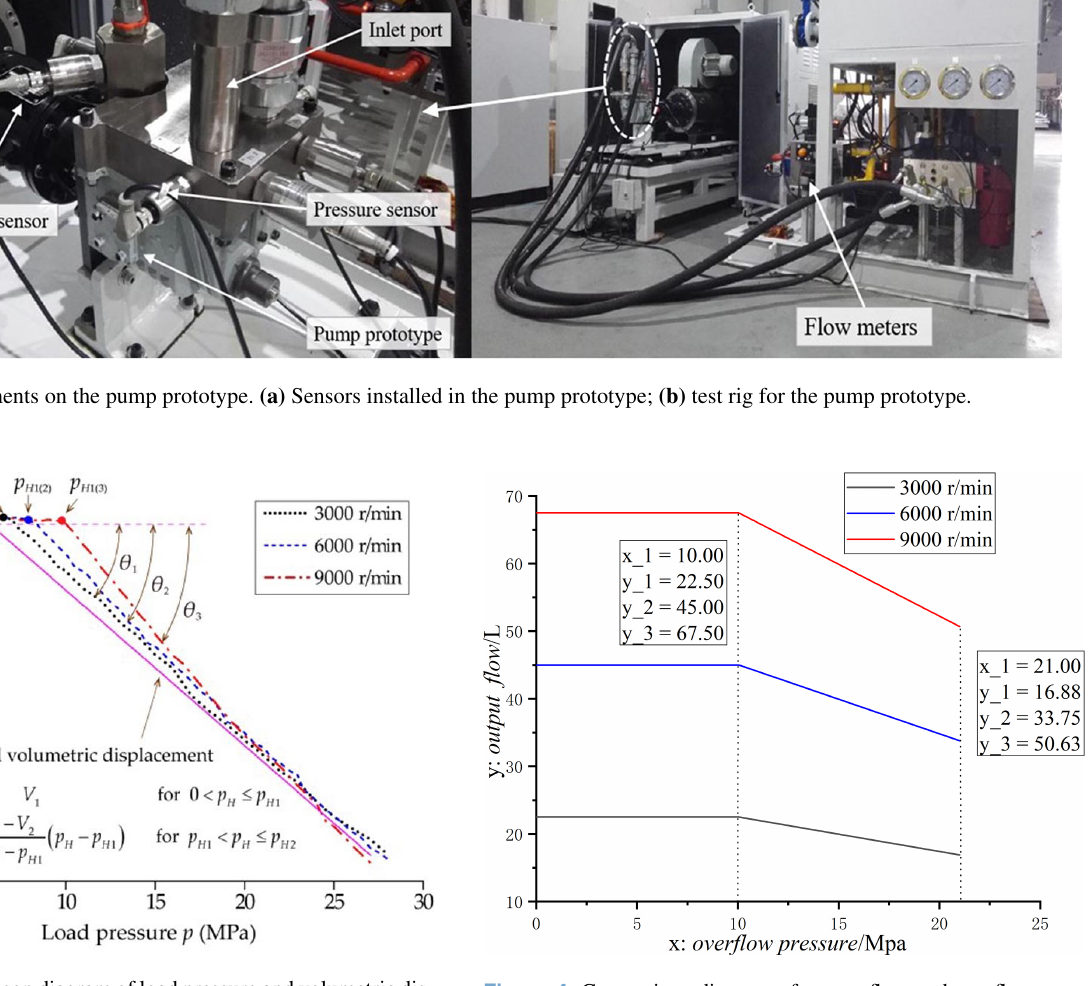
Figure 4. Comparison diagram of output flow and overflow pres-